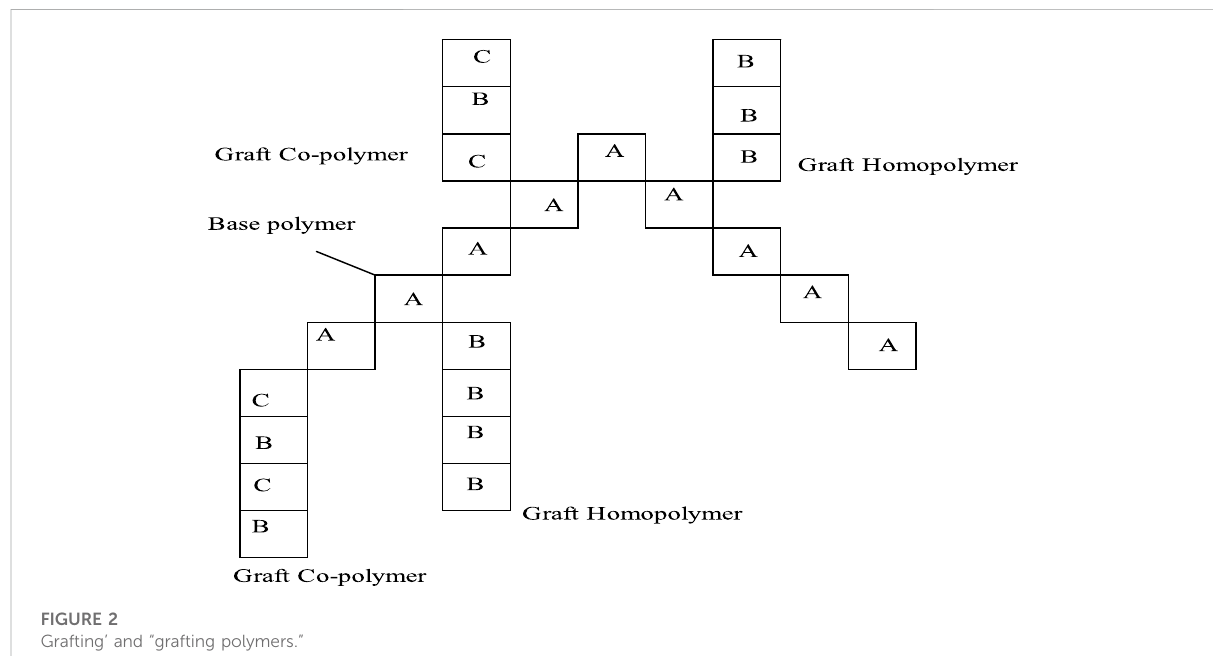
FIGURE 2 Grafting ’ and “ grafting polymers.